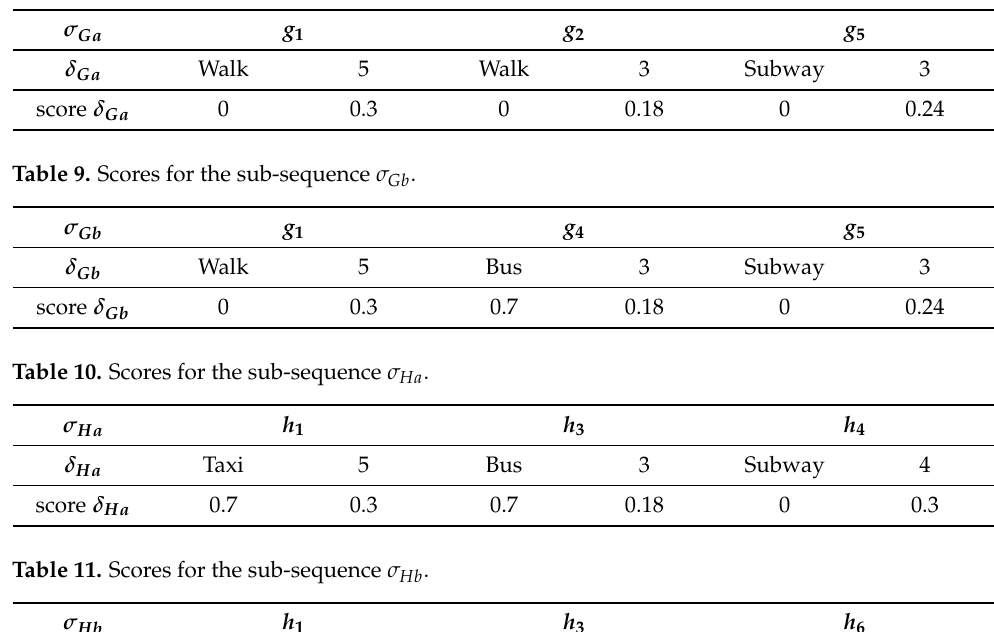
Table 8. Scores for the sub-sequence σ Ga .